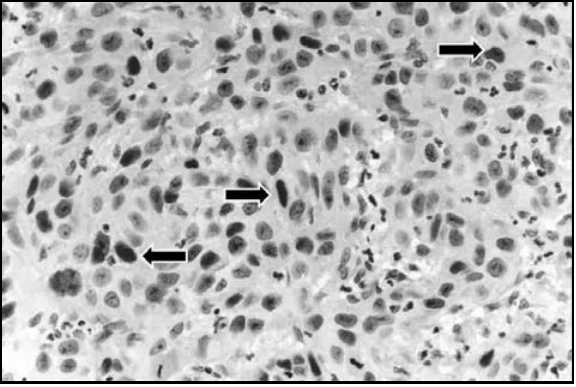
Figura 2 – Carcinoma mucoepidermóide de alto grau de malignidade apresentando inúmeras células positivas para a imunomarcação do antígeno p53, como as apontadas pelas setas (estreptavidina-biotina-peroxidase, aumento original de 400x)